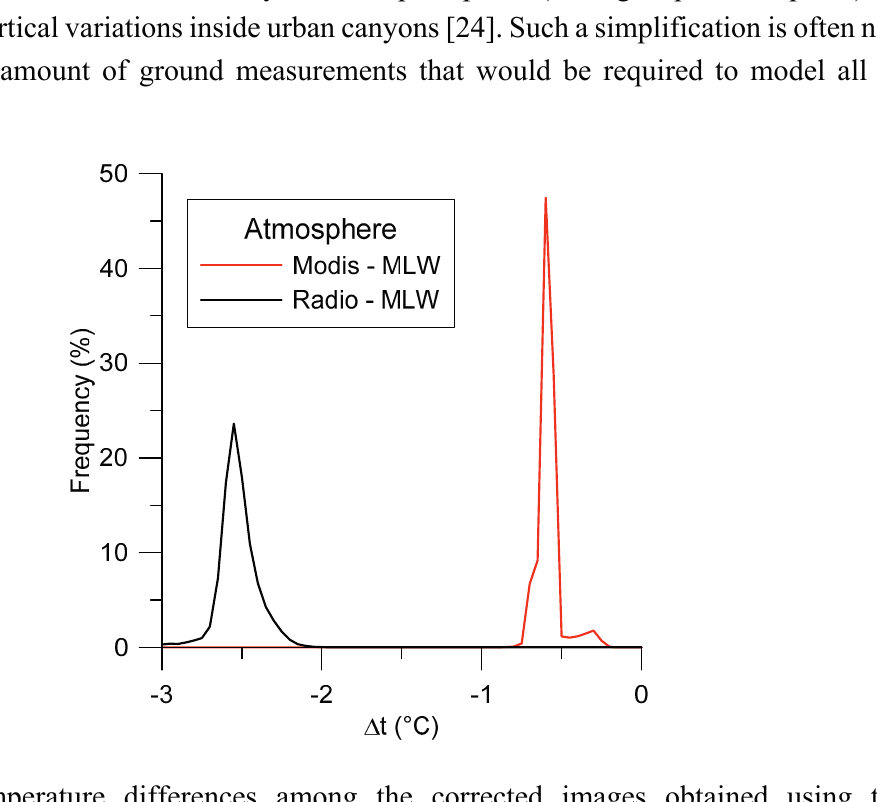
Figure 7. Temperature differences among the corrected images obtained using the atmospheric parameters derived from sounding and MODIS data with respect to the standard MLW